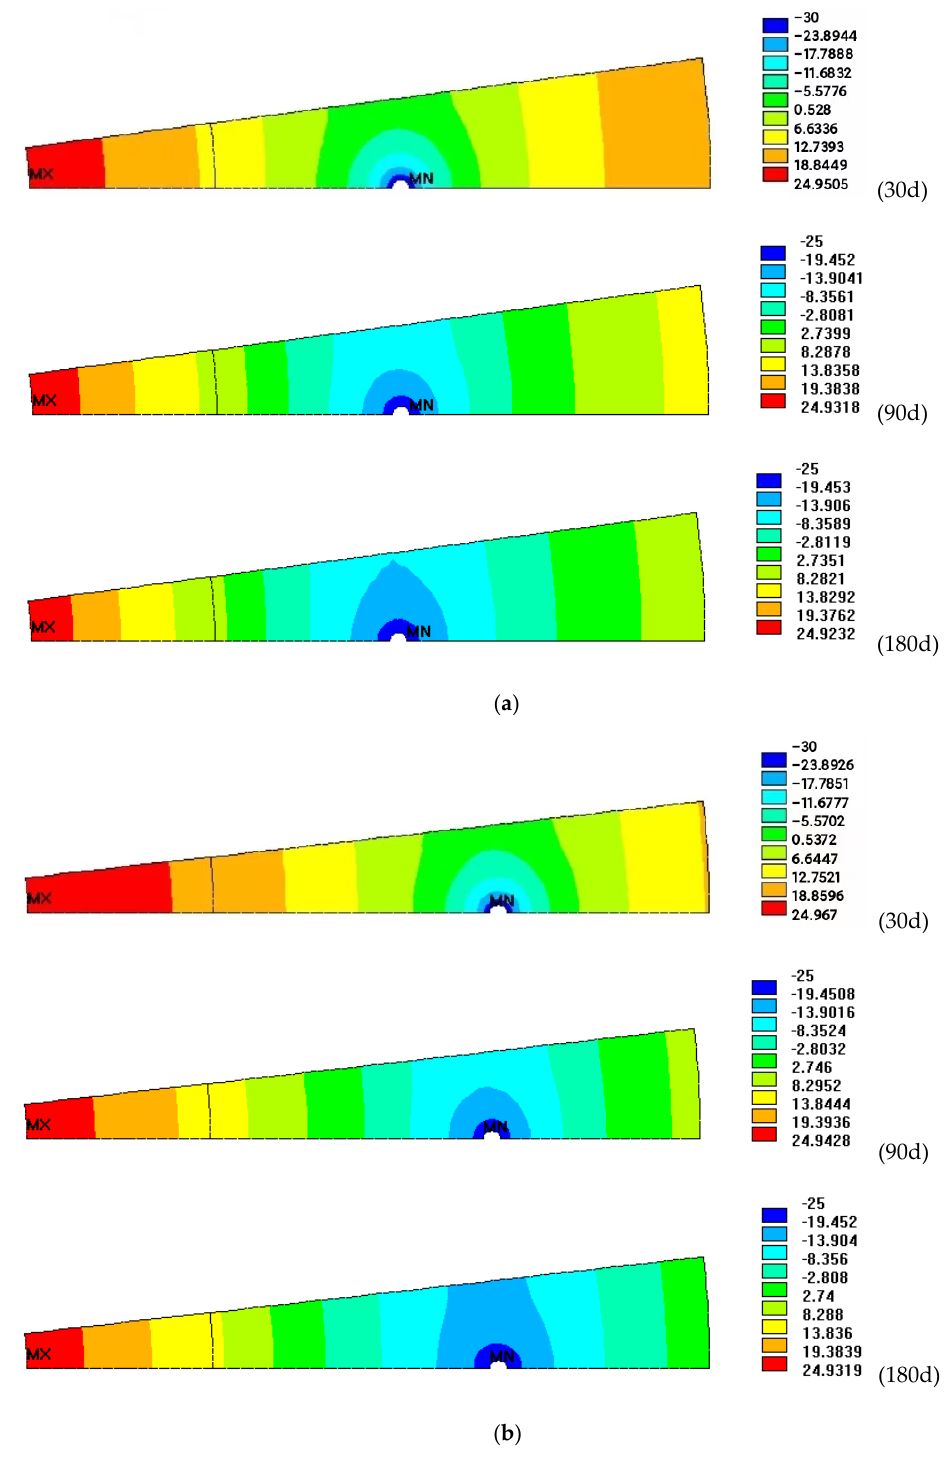
Figure 11. Temperature contours within 30 d, 90 d, and 180 d: ( a ) layout radius of 5.5 m, ( b ) layout radius of 6.3 m.